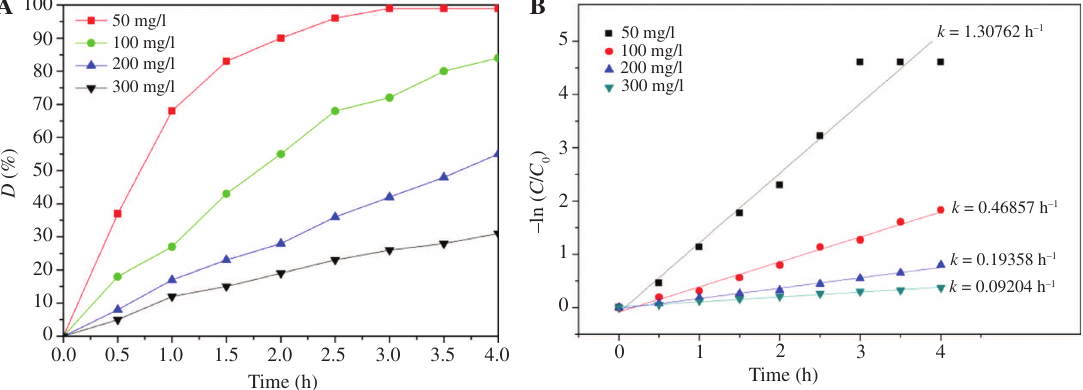
Figure 9: Map (A) and kinetic plot (B) of the degradation of the different initial concentrations of MO with Cu 2 O/ZnO (sample II; catalyst 0.1 g; pH